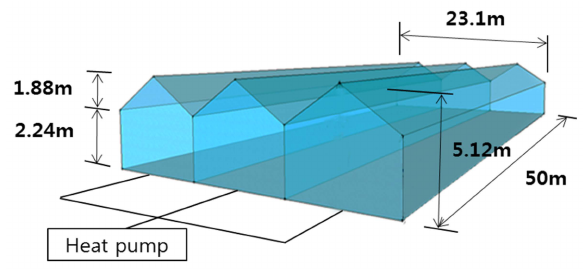
Figure 4. Greenhouse unit